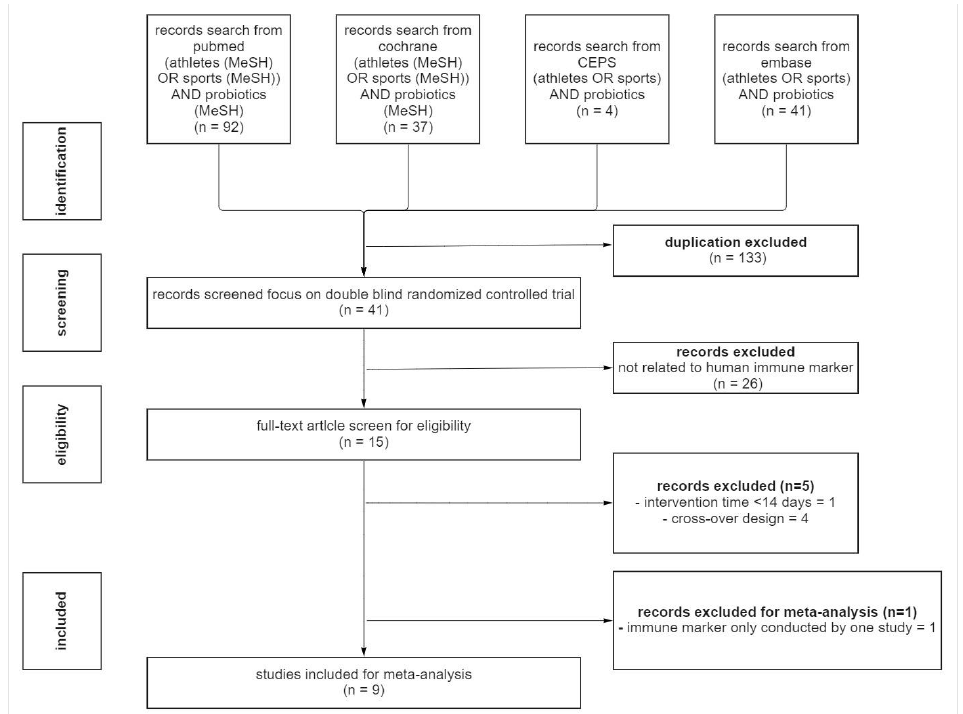
Figure 1. Preferred Reporting Items for Systematic Reviews and Meta-Analysis flowchart of the search strategy.